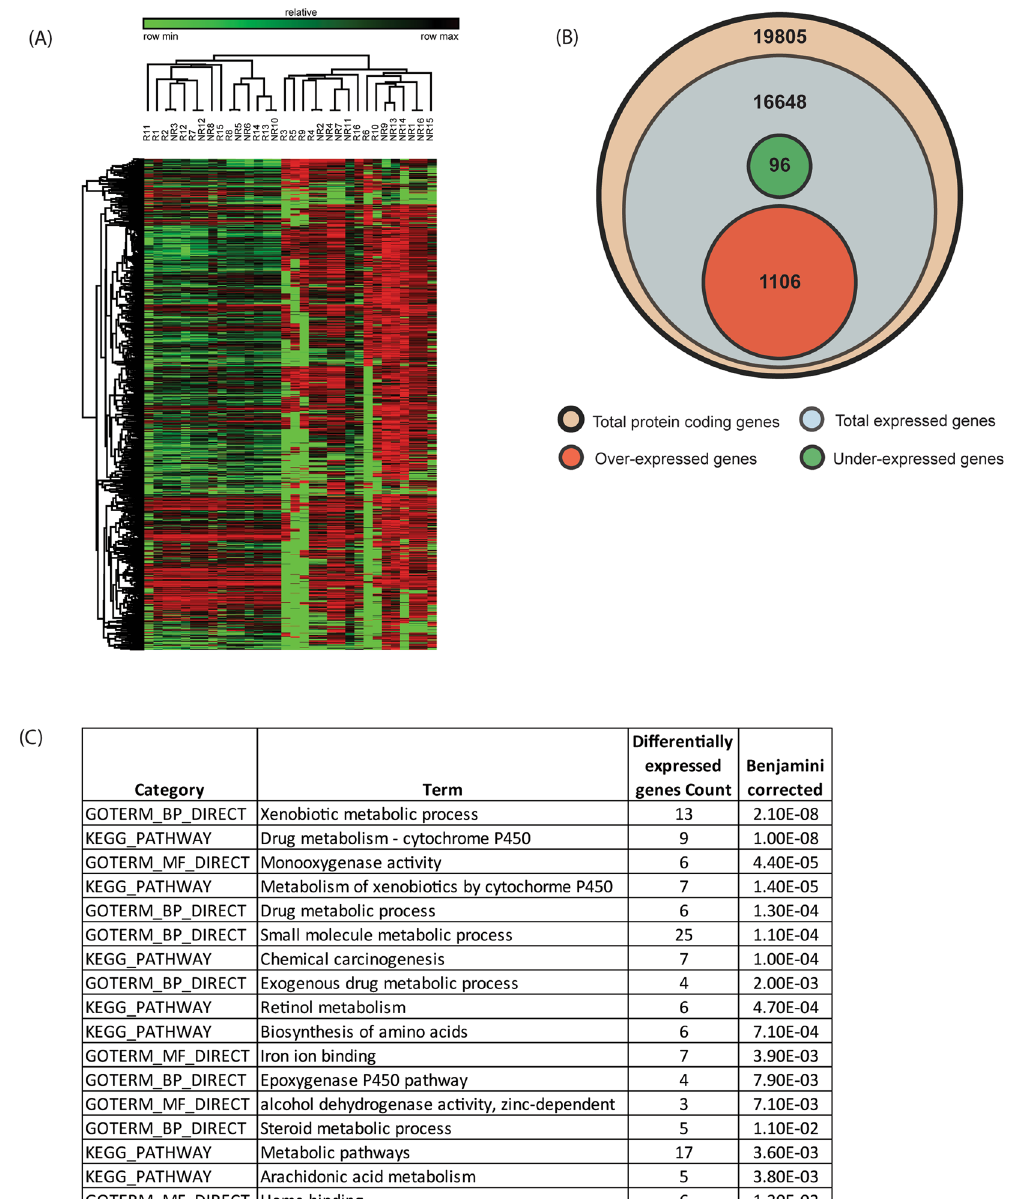
Figure 2. NR vs. R in livers from Indian patients. ( A ) Heat map of genes that were significantly and differentially expressed between NR and R. ( B ) Venn diagram showing the distribution of total genes, total protein coding genes, and differentially up- or down-regulated protein coding genes among NR. ( C ) Functional enrichment based on gene ontology analysis of under-expressewd genes in